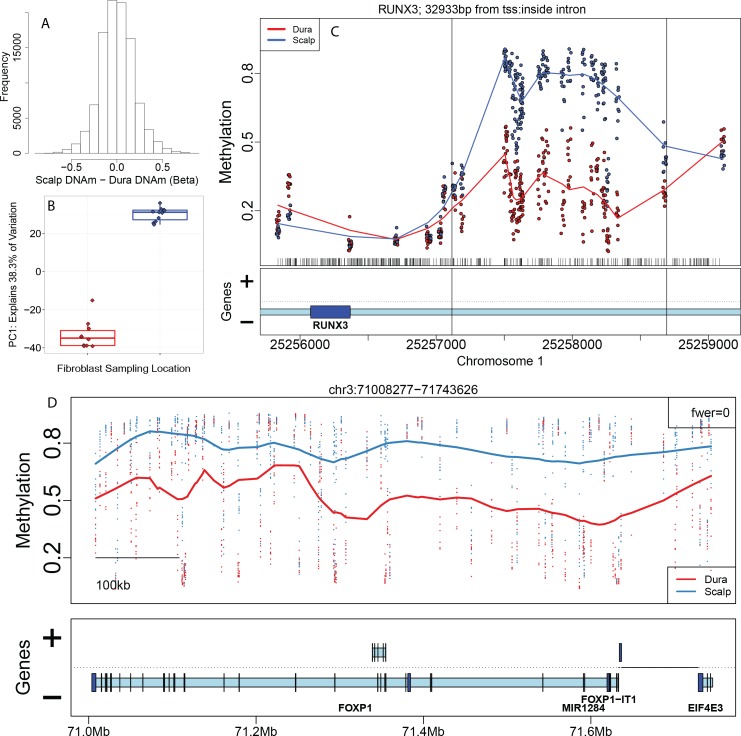
DNA methylation patterns in dura- and scalp-derived fibroblasts.(A) Histogram of difference in DNAm levels at CpGs/probes between scalp and dura derived fibroblasts (on the proportion methylation scale). (B) The first principal component (PC1) of the DNAm data plotted against fibroblast sampling location (scalp versus dura). (C) Example significant differentially methylated region (DMR) that overlaps the gene RUNX3, with DNAm levels on the y-axis and genomic coordinates on the x-axis. (D) Example significant DNAm block, with DNAm levels on the y-axis and genomic coordinates on the x-axis. Gene annotation panels in C and D are based on Ensembl annotation–dark blue represents exons and light blue represents introns.